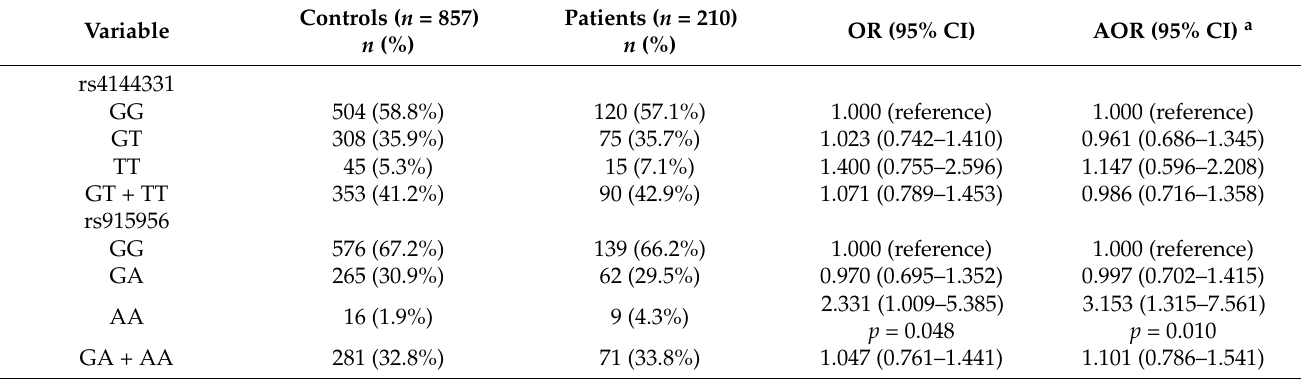
Table 3. Genotyping and allele frequency of TRIM-21 single nucleotide polymorphism (SNP) among age <65 years old HCC and normal